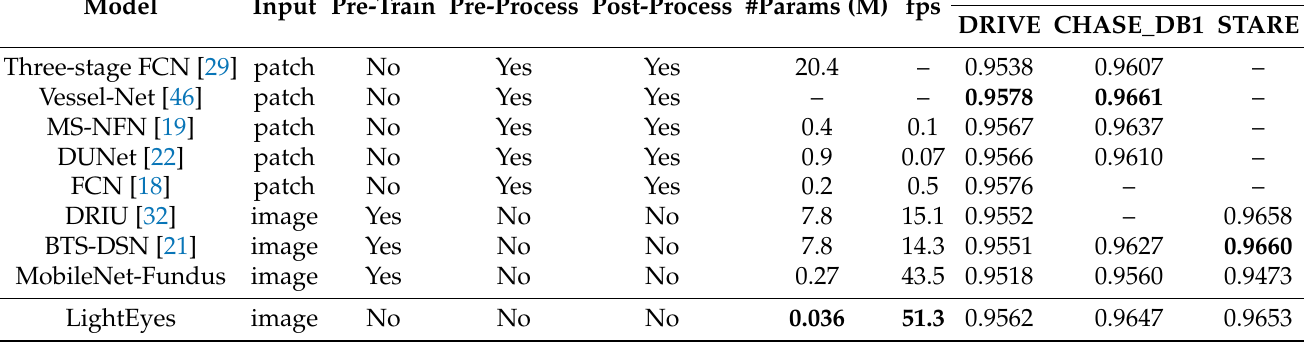
Table 8. Comparison of proposed method and other vessel segmentation models (in the table, fps = 1/ t i , where t i is the forward propagation time of a single image with size 584 ×